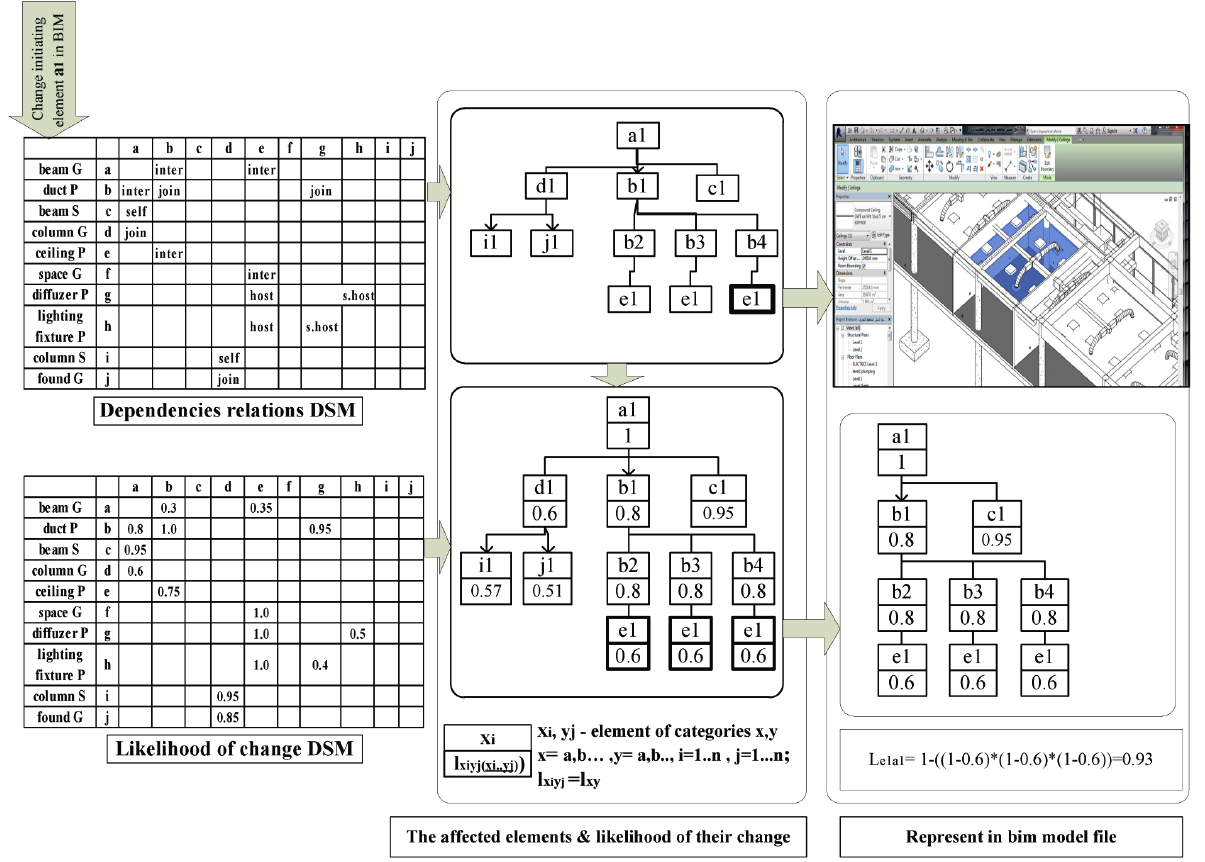
Fig. 11. Methodology applied for predicting change